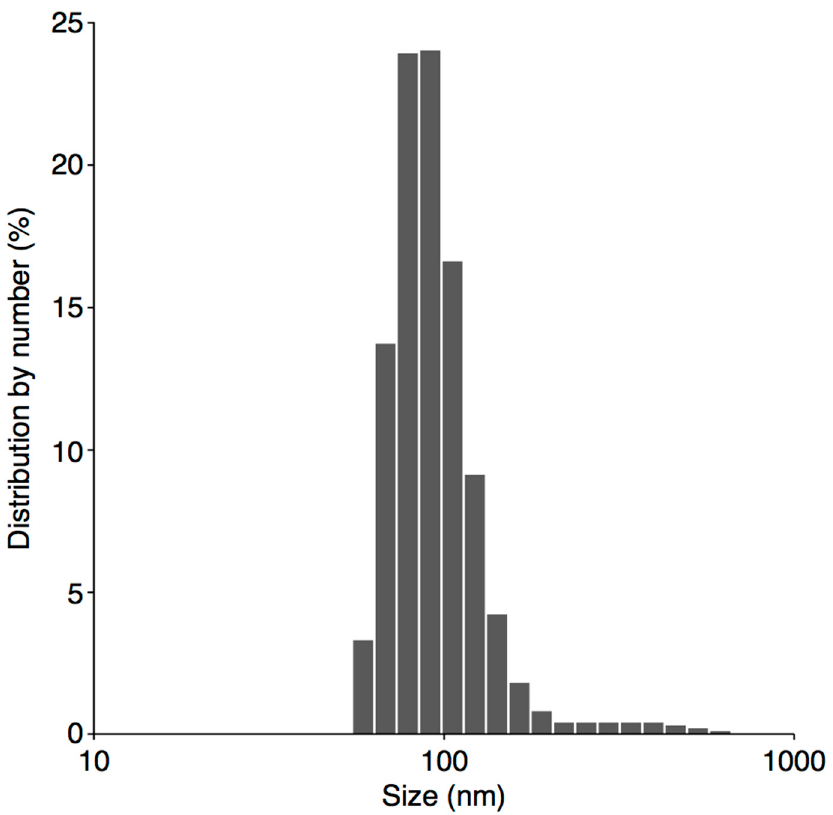
Figure 5. A histogram displaying size by number distribution of PVP-PtNPs as determined by DLS.